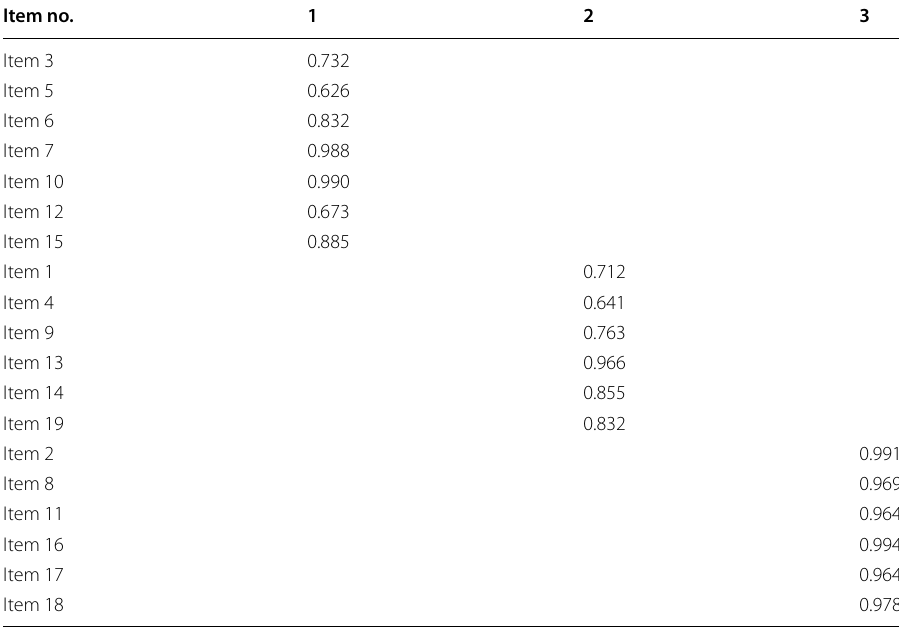
Table 4 Rotated matrix of factors based on PCA and Varimax Item